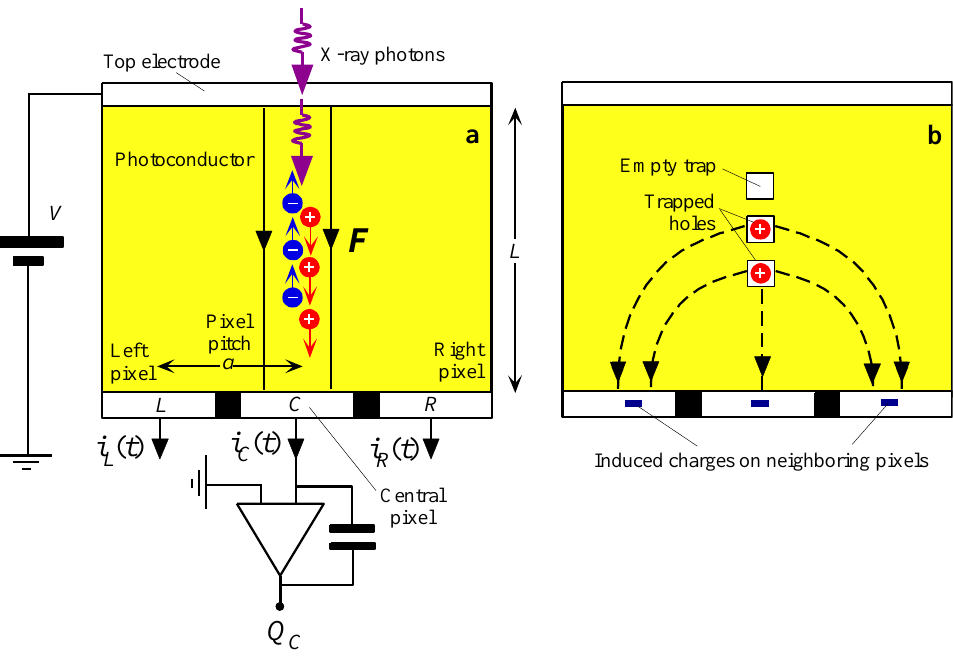
Figure 6. (a) X-ray photons are incident on a central reference pixel C and are absorbed in the photoconductor over C . The x-ray generated electrons and holes drift respectively towards positive and negative electrodes, the latter being pixellated. There is no trapping and recombination and all the generated charges are collected. (b) Holes are